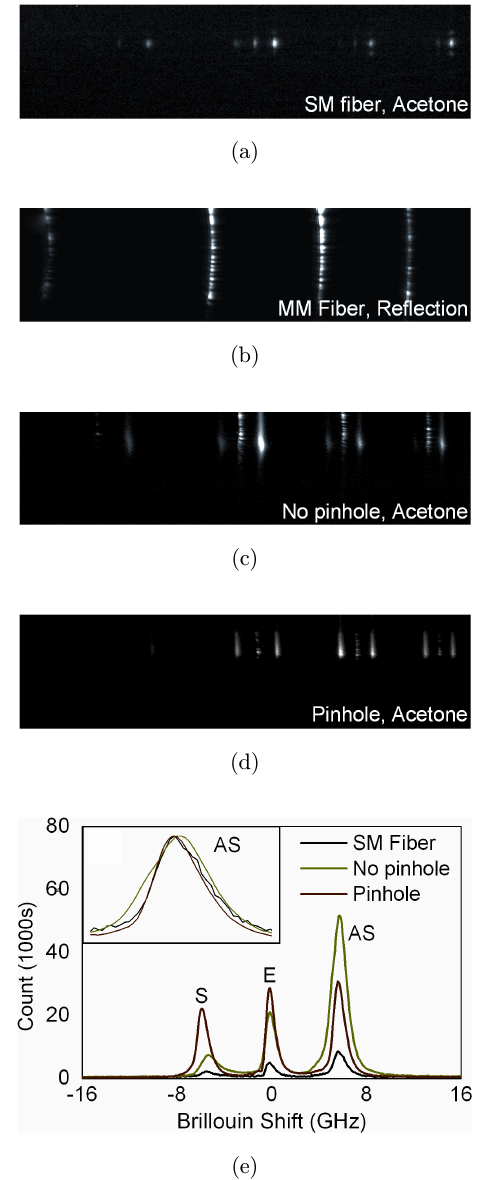
Fig. 2. CCD images acquired with di®erent setups utilizing (a) a SM ¯ber, (b) a multi-mode ¯ber, (c) open space without pinhole and (d) open space with a pinhole. (e) the retrieved Brillouin spectra for each setups. The \SM ¯ber" result has been zoomed-in by 3 times. S: Stokes peak; AS: anti-Stokes Peak; E: Elastic peak. We used acetone as the sample in all tests except (b). Incident power: 35 mW. Integration time: 4